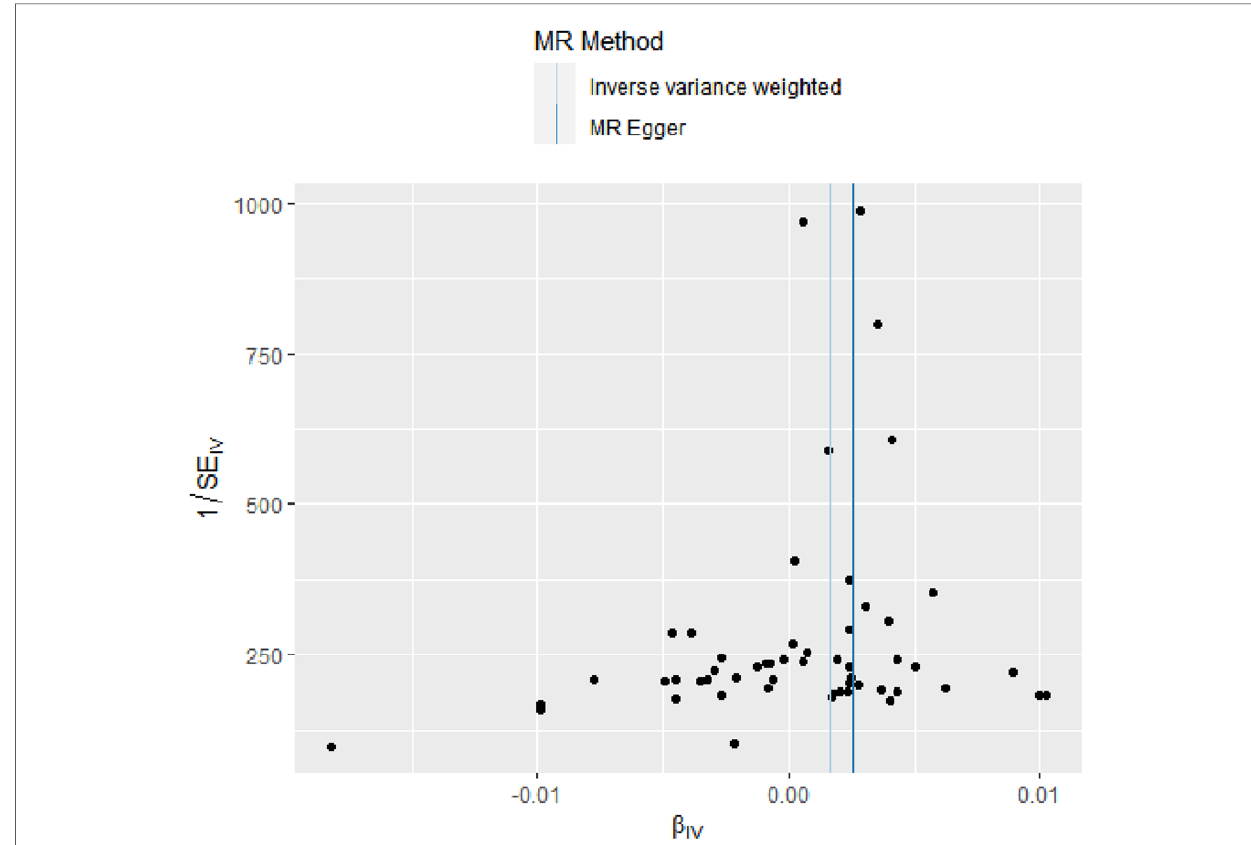
FIGURE 4 Funnel plot for RA on coronary atherosclerosis. This plot can be used for visual inspection of symmetry, where any deviation can be suggestive of pleiotropy. Each SNP ’ s MR estimate is plotted against its minor allele frequency corrected association with RA. We note that our plot appears generally symmetrical. SNPs, single nucleotide polymorphisms. MR, Mendelian randomization; RA, rheumatoid